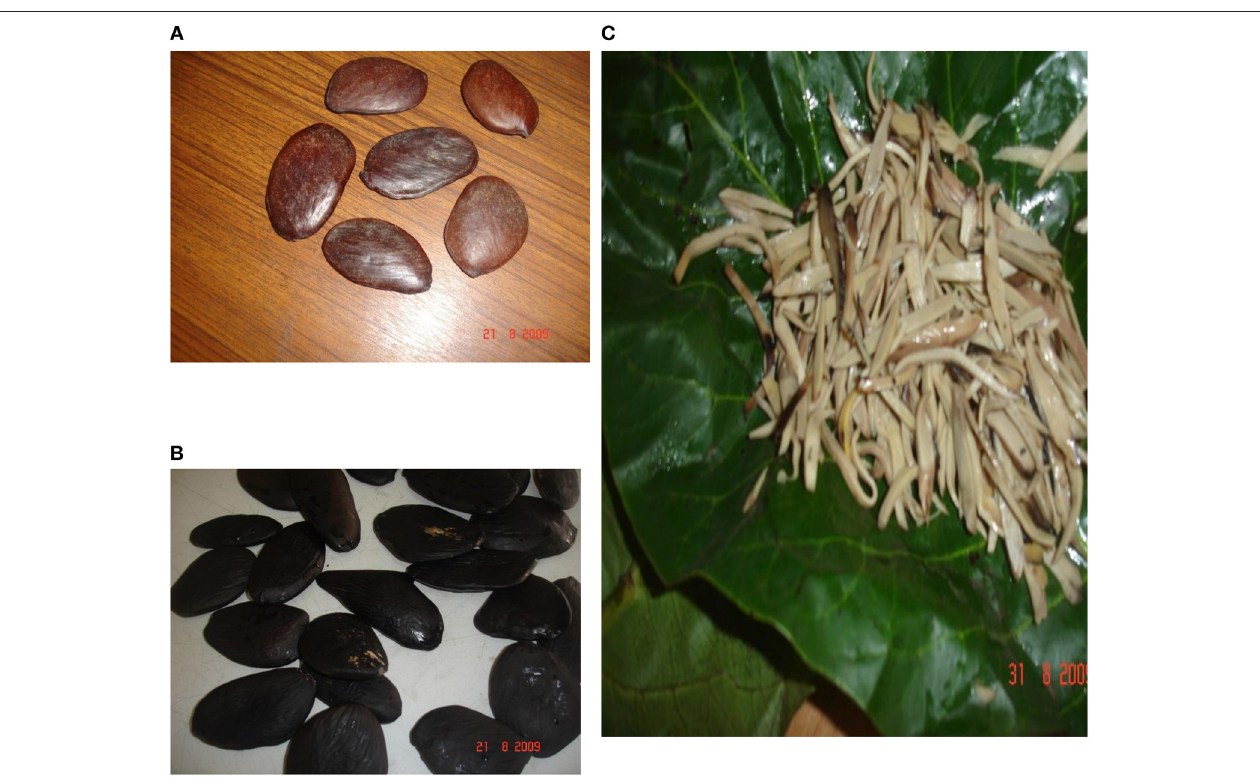
FIGURE 1 | African oil bean seed (A), Dehulled seeds of African oil bean (B) and Processed slices of the African oil bean cotyledon (C). (Okorie and Olasupo, 2013a